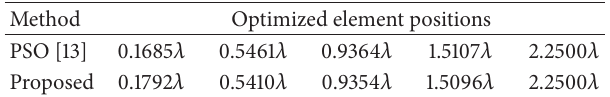
Table 7: Comparative analysis of null depth (in dB) obtained by various optimization algorithms for Example 3 .